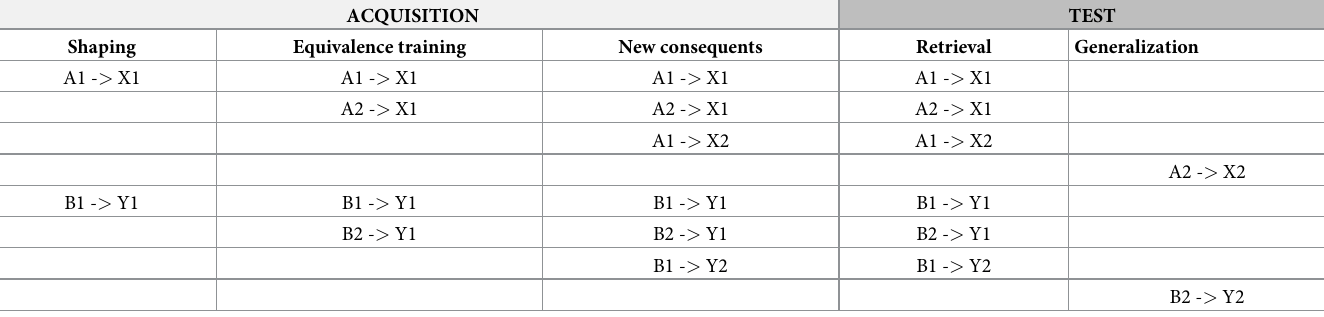
Table 1. Summary of the visual and audiovisual associative learning